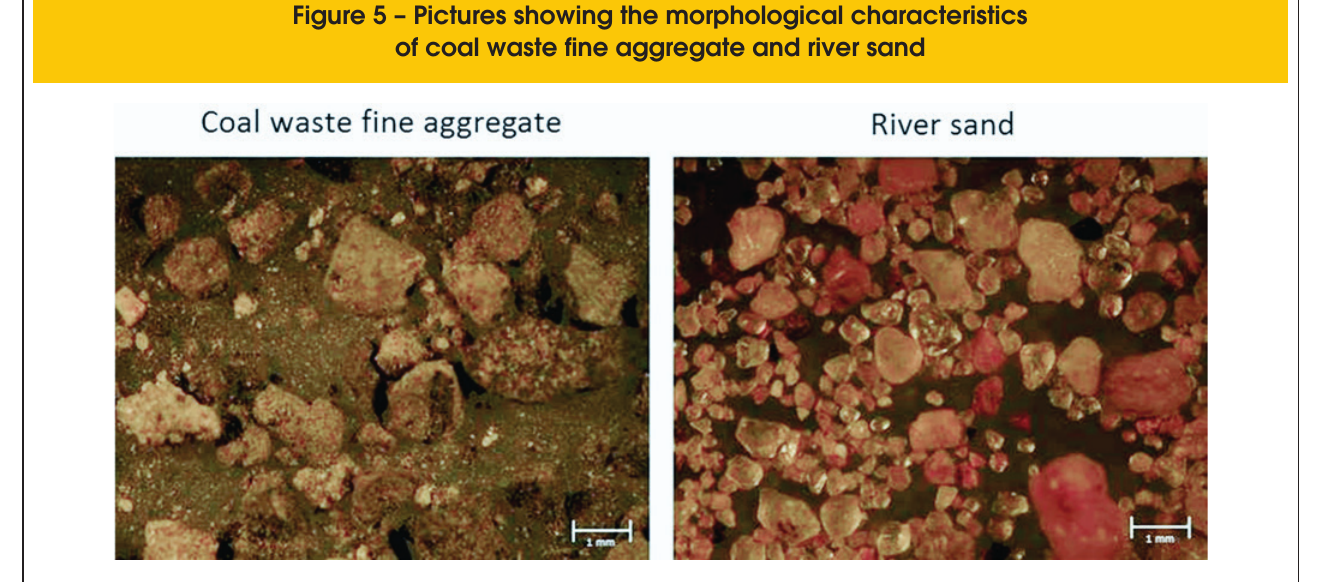
Figure 5 – Pictures showing the morphological characteristics of coal waste fine aggregate and river